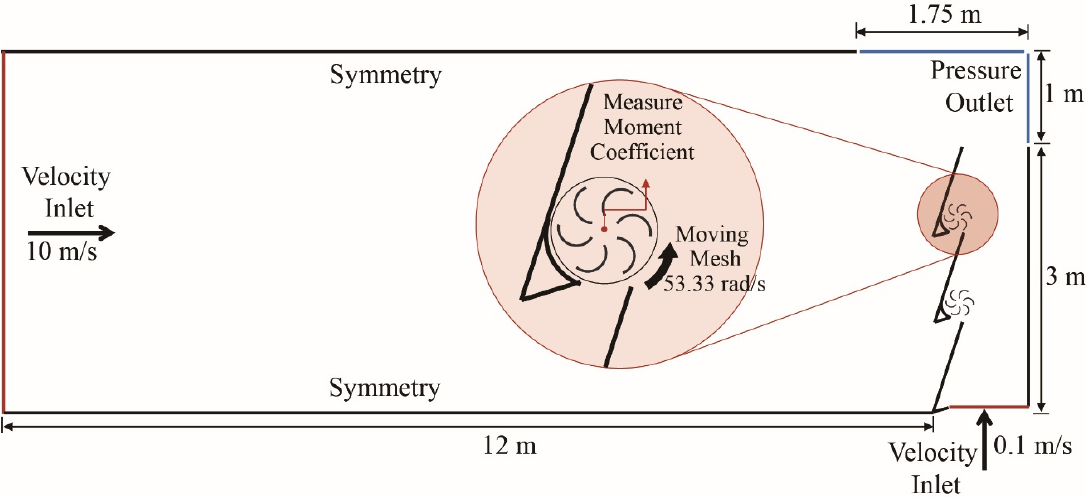
Figure 10. CFD simulation domain for the rotor